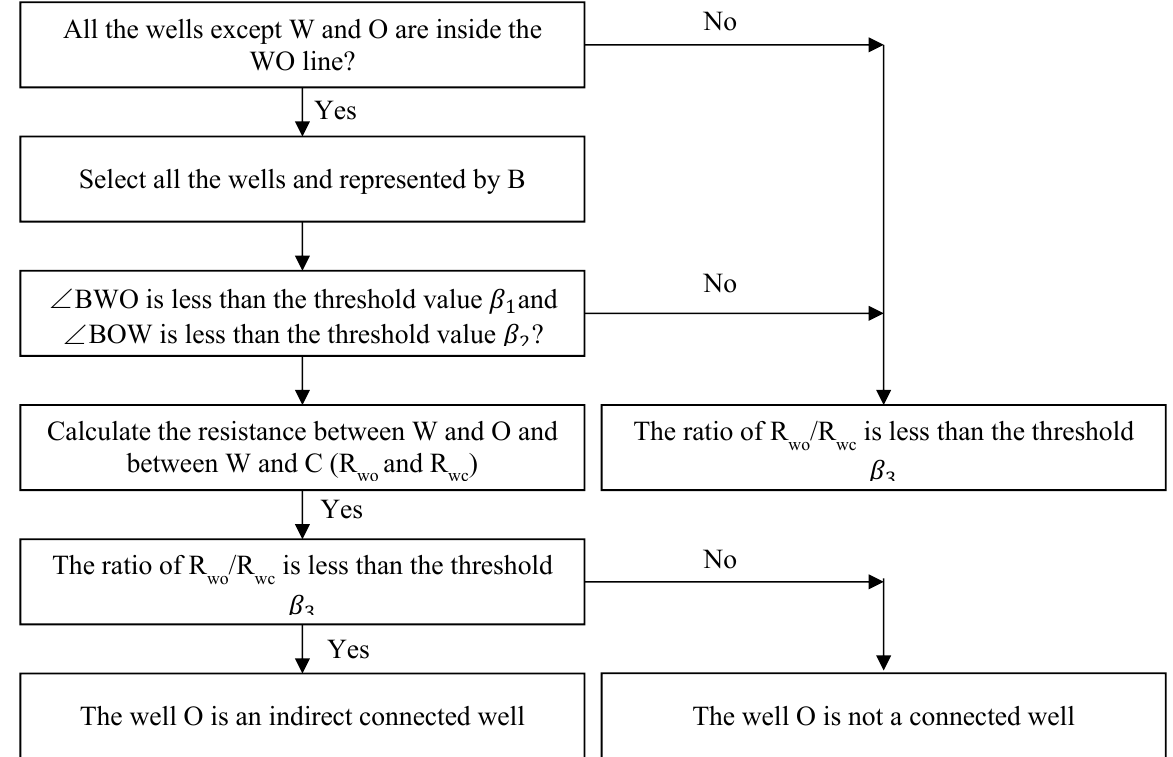
Figure 5—The discrimination flow of indirect connections.